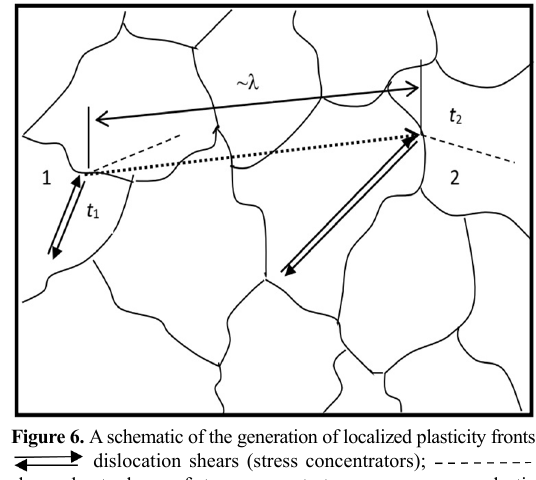
Figure 6. A schematic of the generation of localized plasticity fronts dislocation shears (stress concentrators); shears due to decay of stress concentrators; elastic pulse